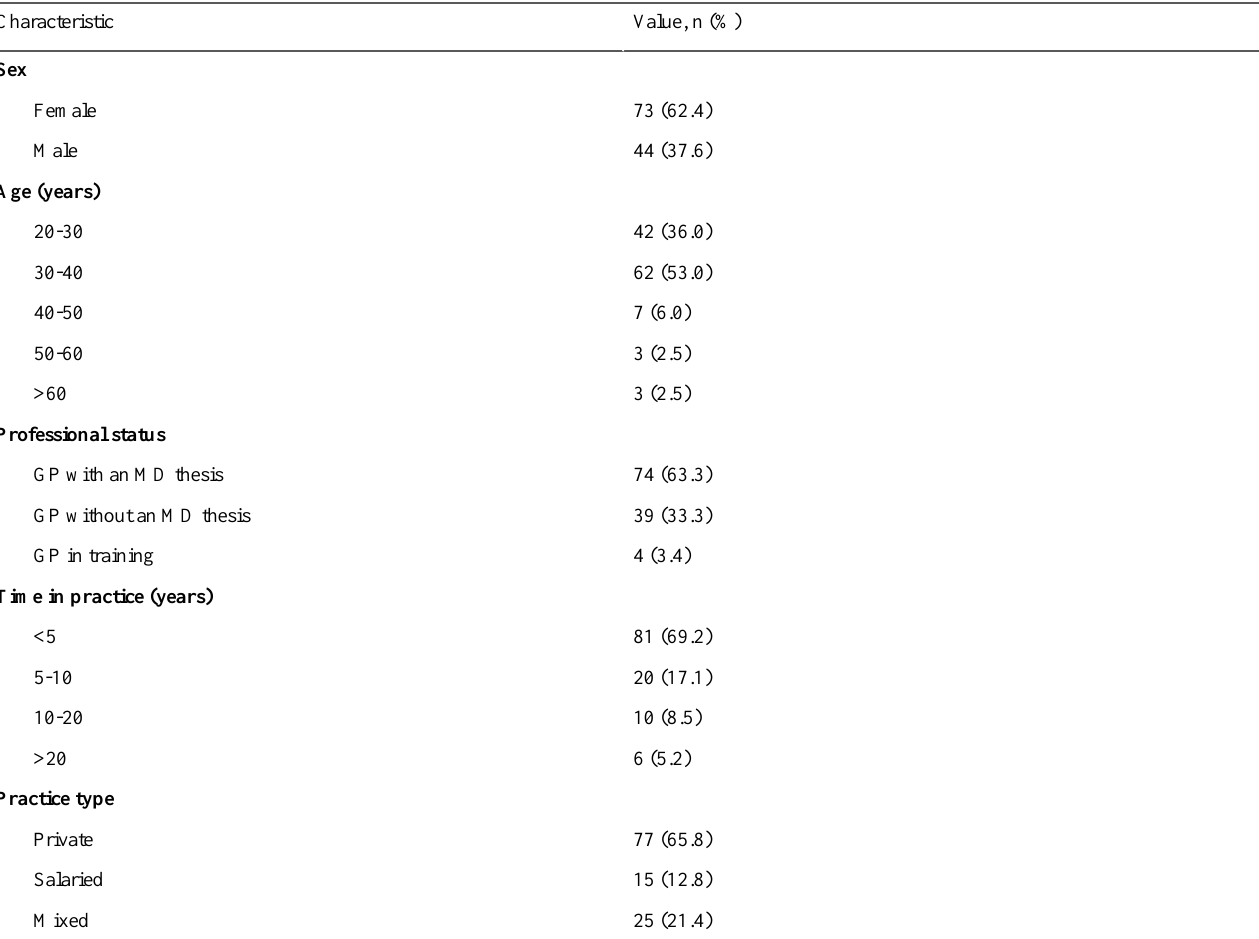
Table 2. Sociodemographic characteristics of the general practitioners (GPs)